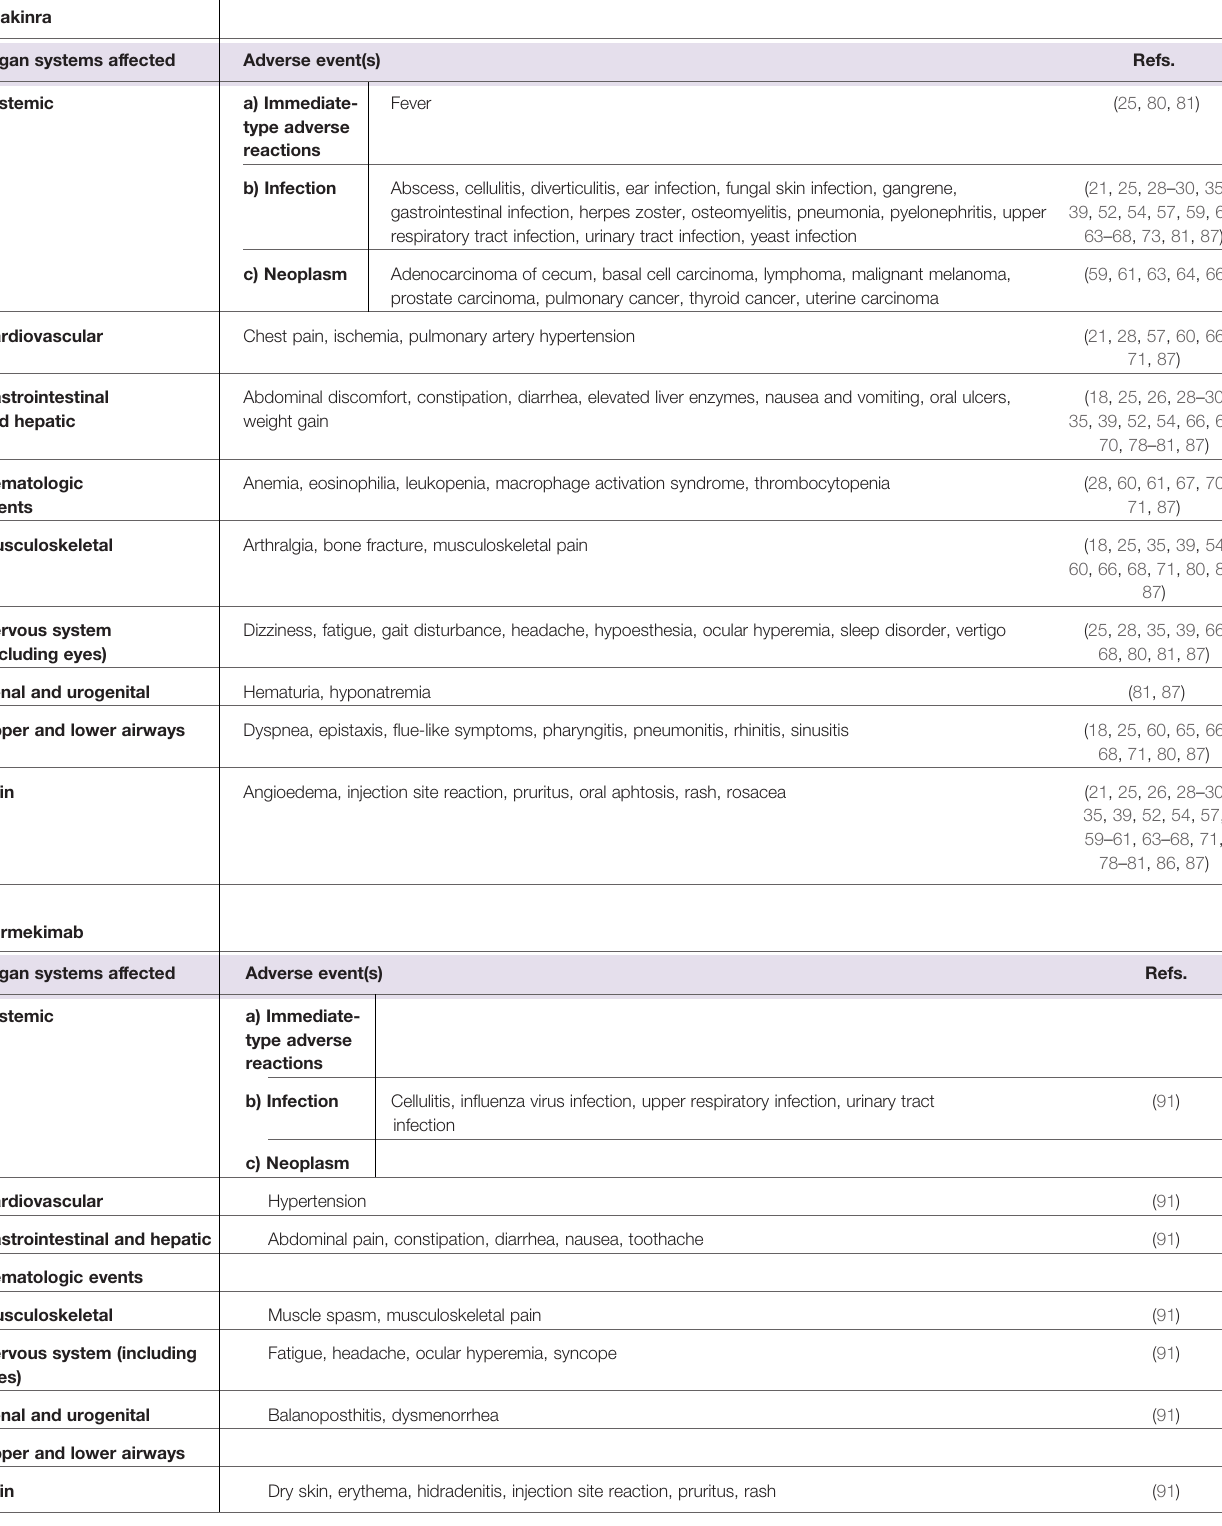
TABLE 3 | Adverse events.